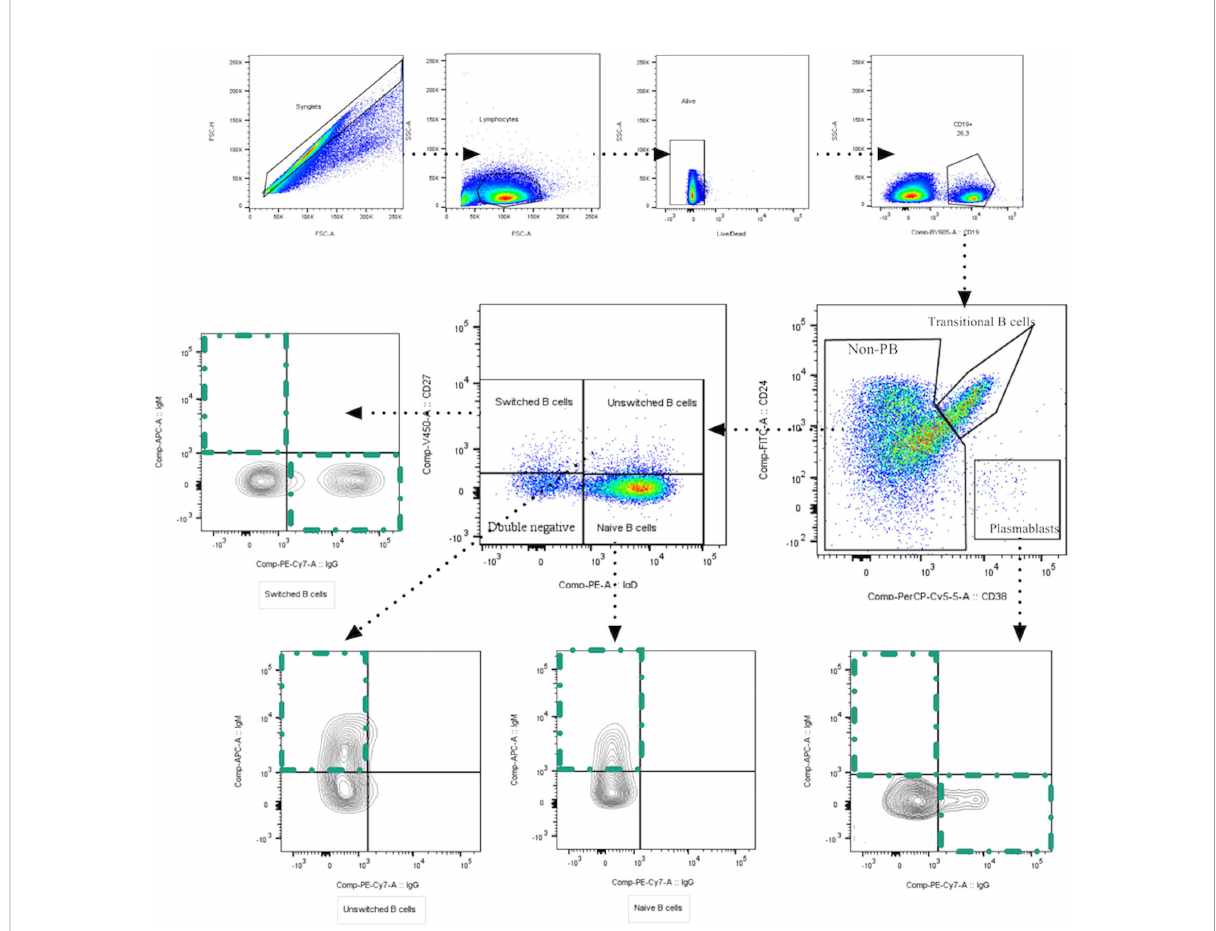
FIGURE 1 Gating strategies to identify B cell subpopulations. Representative plots show a singlets gate identi fi ed by FSC-H vs. FSC-A parameters followed by FSC vs. SSC plot to identify the total lymphocyte population. Live cells were selected based on negative live/dead staining. Subsequently, CD19+ B cells were set, and several B cells subpopulations were identi fi ed based on the expression of surface markers: transitional B cells (CD24 + CD38 High ); plasmablasts (CD24 - CD38 High ) that express IgM + , IgG + or IgG - /IgM - ; naïve B cells (CD24 + IgD + CD27 - ); memory B cells (MBCs, CD24 + CD27 + IgD + ) that could be classi fi ed in IgM-expressing unswitched and IgM-negative memory B cells (only IgD + ); memory B cells CD27 + IgD - that express IgM (pre-switched memory cells), and that express IgG (switched memory cells); and double negative B cells (DN) (CD24 + CD38 + CD27 - IgD - IgG -